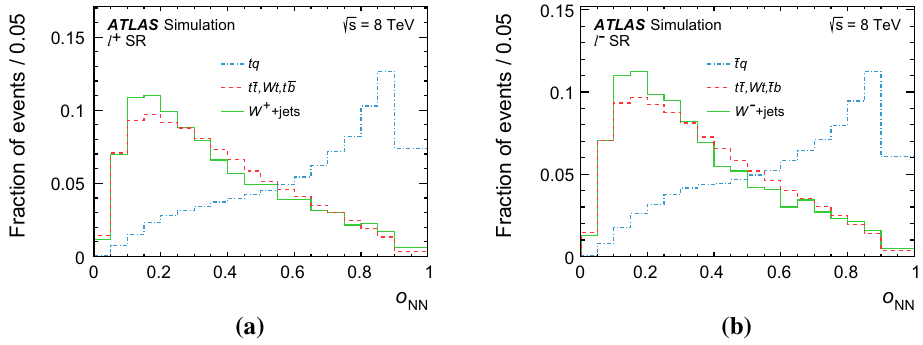
Fig. 4 Probability densities of the NN discriminants in the signal region (SR) for the tq and ¯ tq signal processes, the W +jets background and the top-quark background: a in the (cid:5) + SR and b in the (cid:5) − SR